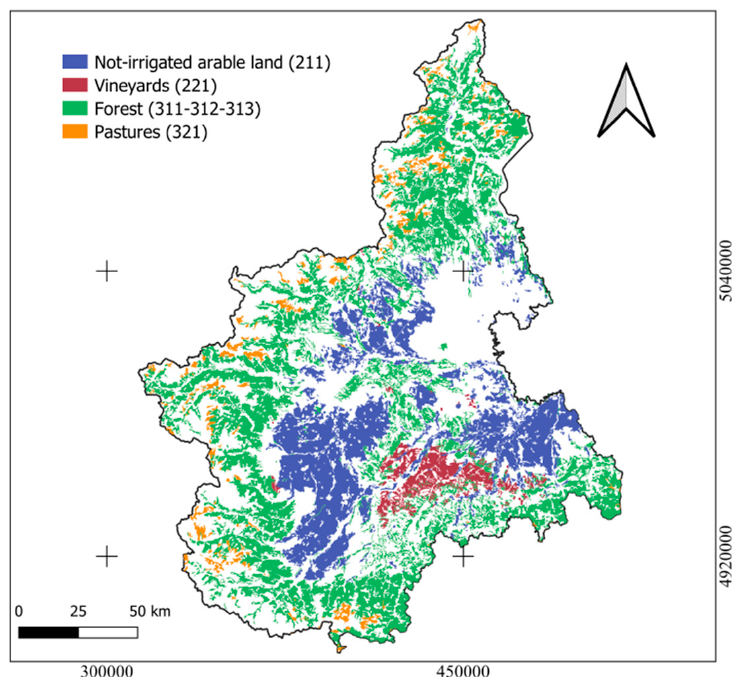
Figure 3. Agricultural and natural classes obtained by intersection of the four CLC maps (Reference frame: WGS 84/UTM zone 32N, EPSG: 32632).